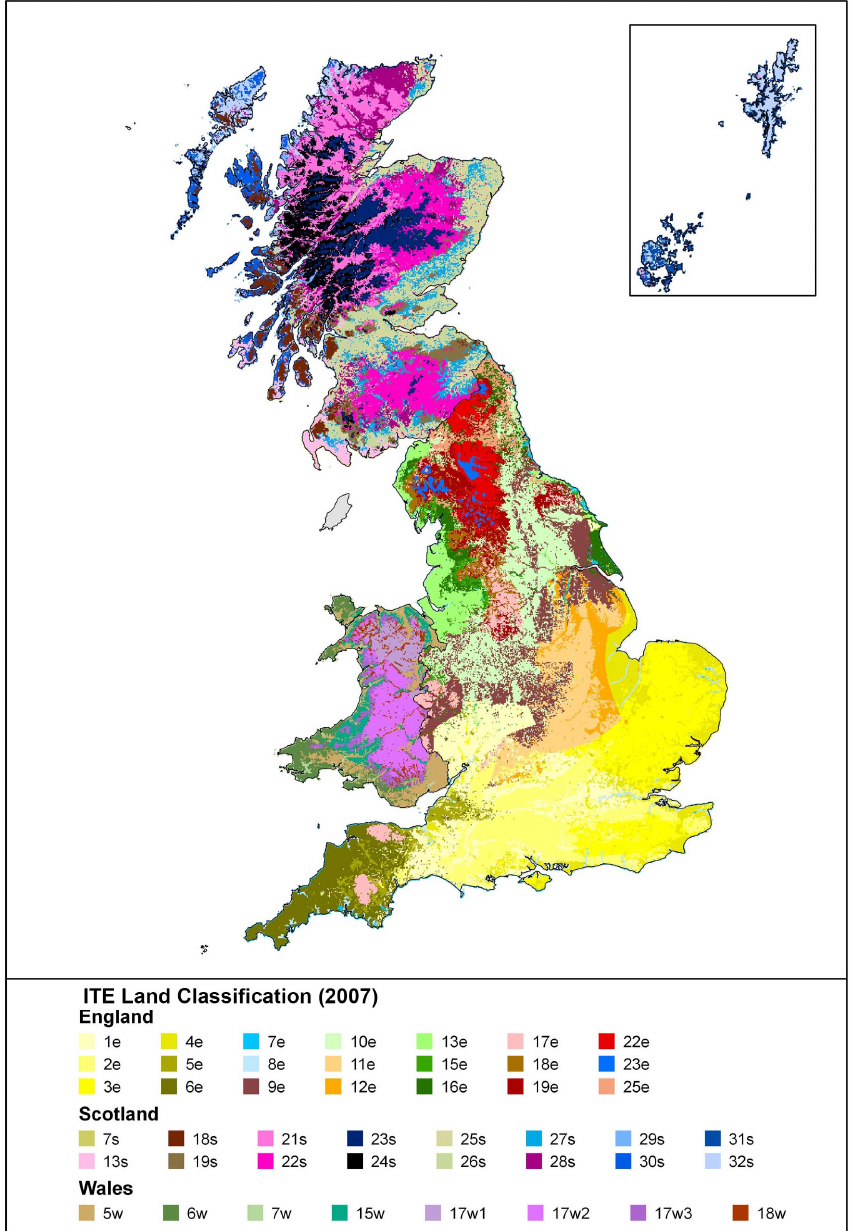
Figure 2. ITE Land Classification, 2007. (Contains Ordnance Survey data (©) Crown copyright and database right 2018.)